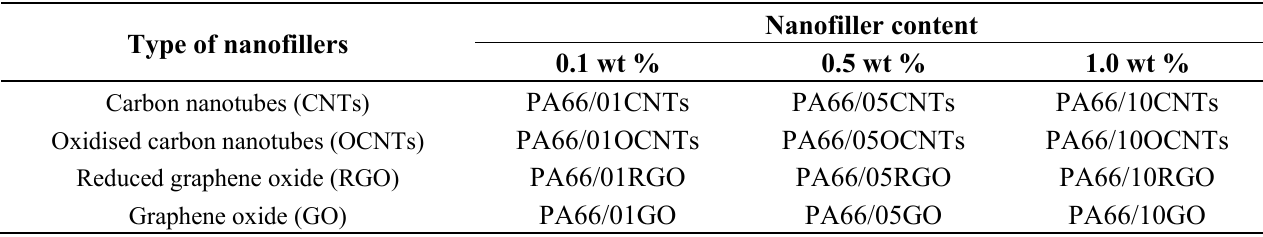
Table 1. Nomenclature of the electrospun fibres.